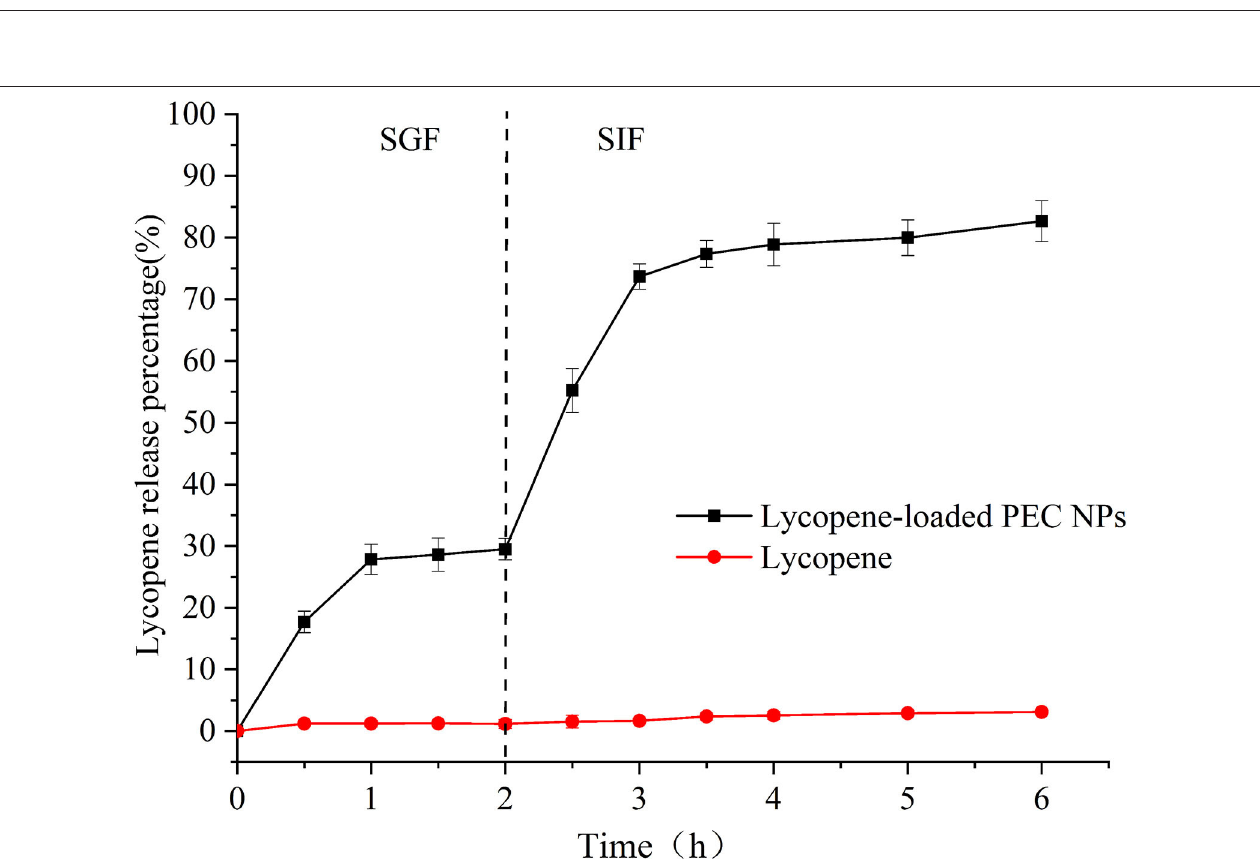
Frontiers in Nutrition |